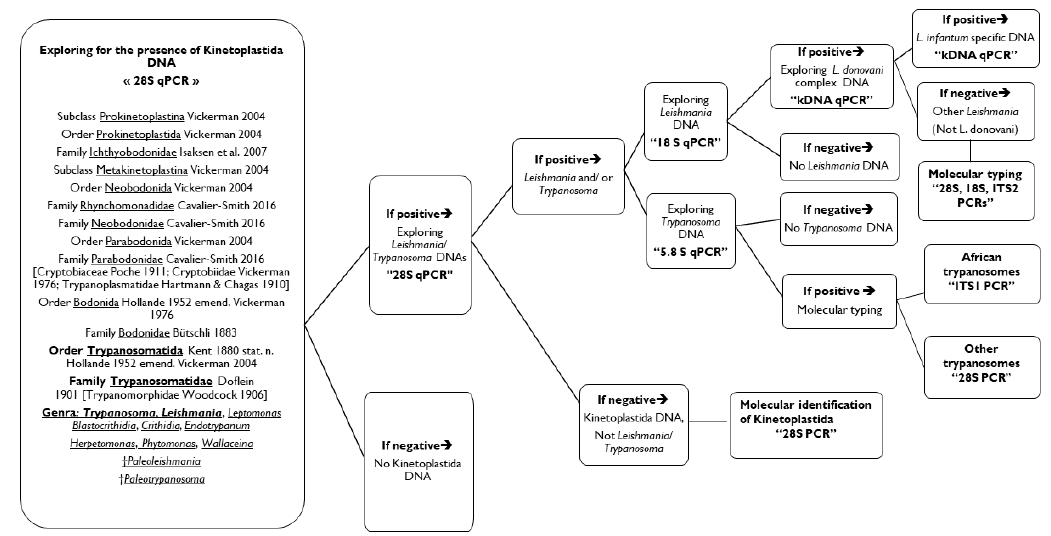
Figure 2. Proposal of the molecular approach for the complete diagnosis of Kinetoplastida in human and animal samples.